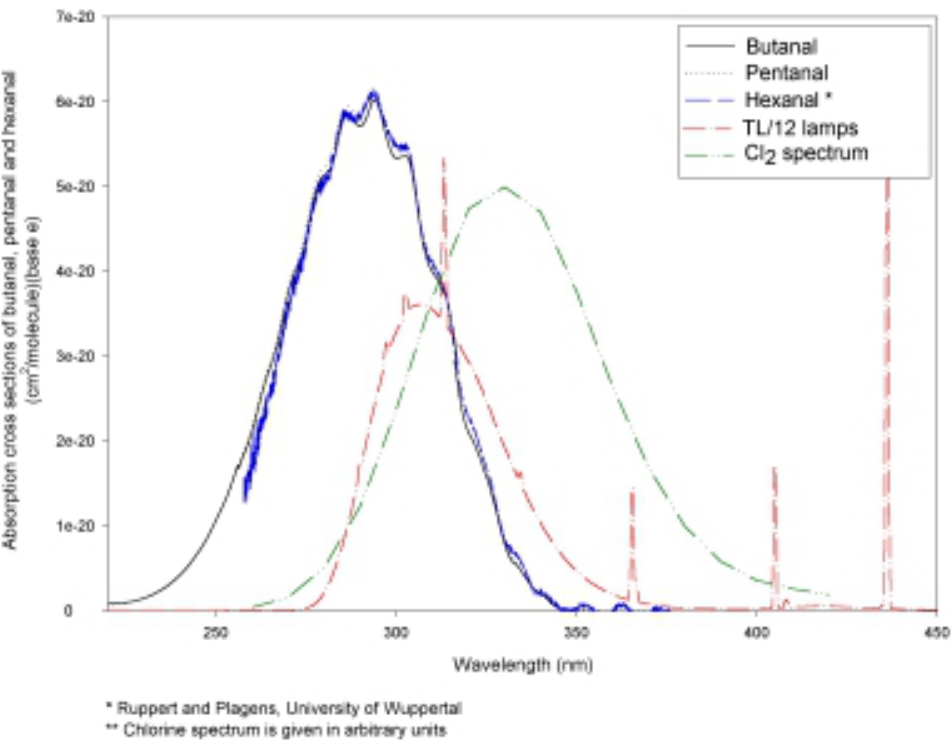
Figure 5. Emission spectrum of photolysis lamps (TL12/Philips), absorption spectrum of Cl and cross section of n -hexanal [23]. Cross sections of butanal and pentanal are 2 also given for comparison. Figure explains why chlorine was used as actinometer, and why TL12 lamps were chosen for photolysis, since there is a good overlap of all three